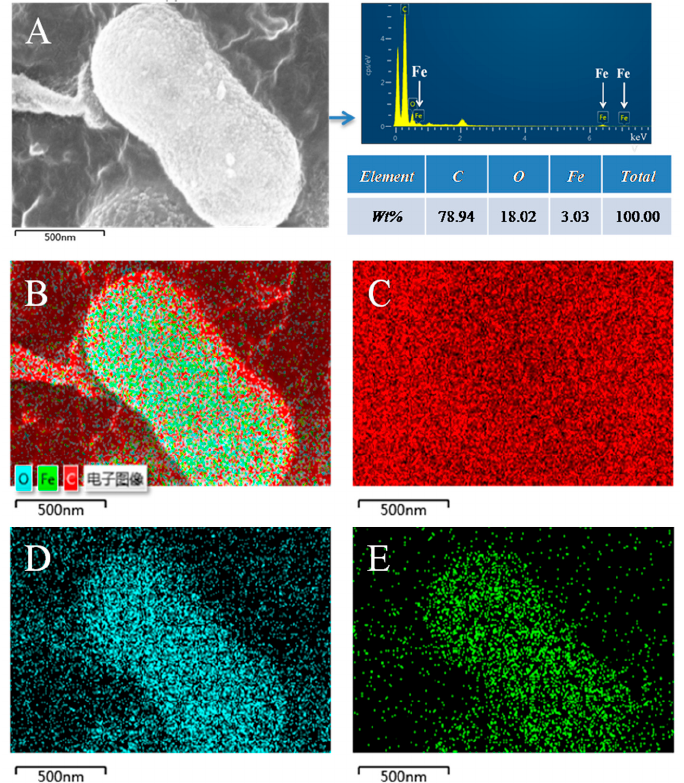
Figure 4. FESEM images of strain F1 and the surface contents analysis by EDS. ( A ) The view of the targeted cell and the composition of main elements. ( B ) Overlay chart of the distribution of carbon, oxygen, and iron. ( C ) Distribution of carbon in the view. ( D ) Distribution of oxygen in the view. ( E ) Distribution of iron in the view.